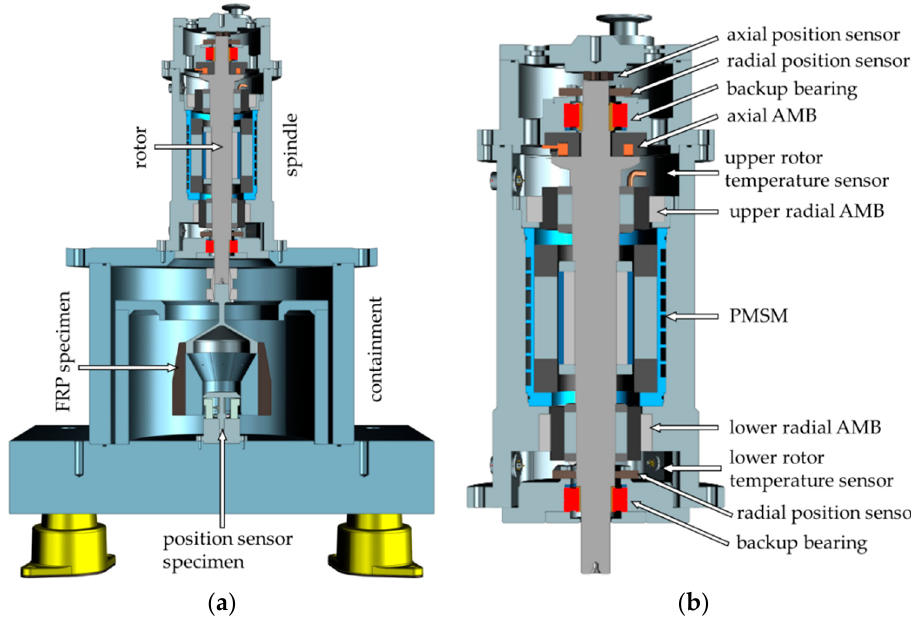
Figure 2. ( a ) Cross section of the test rig; ( b ) Cross section of the spindle.